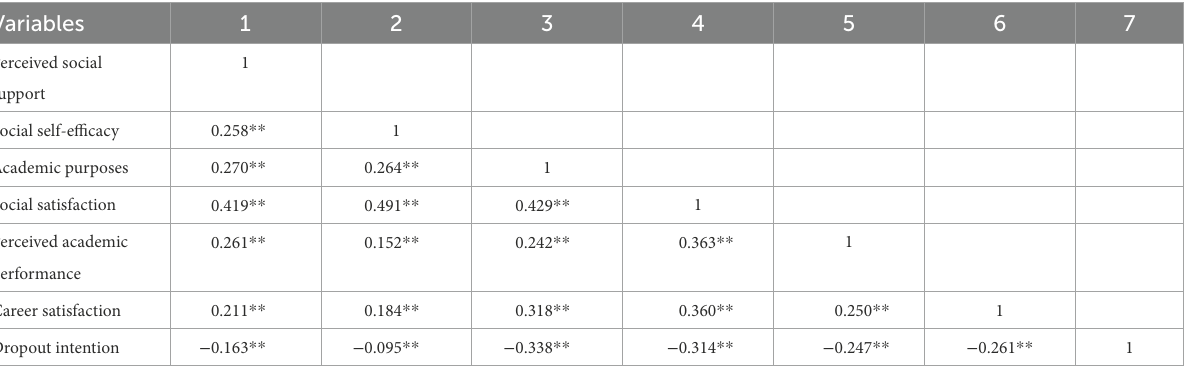
TABLE 3 Correlations between model